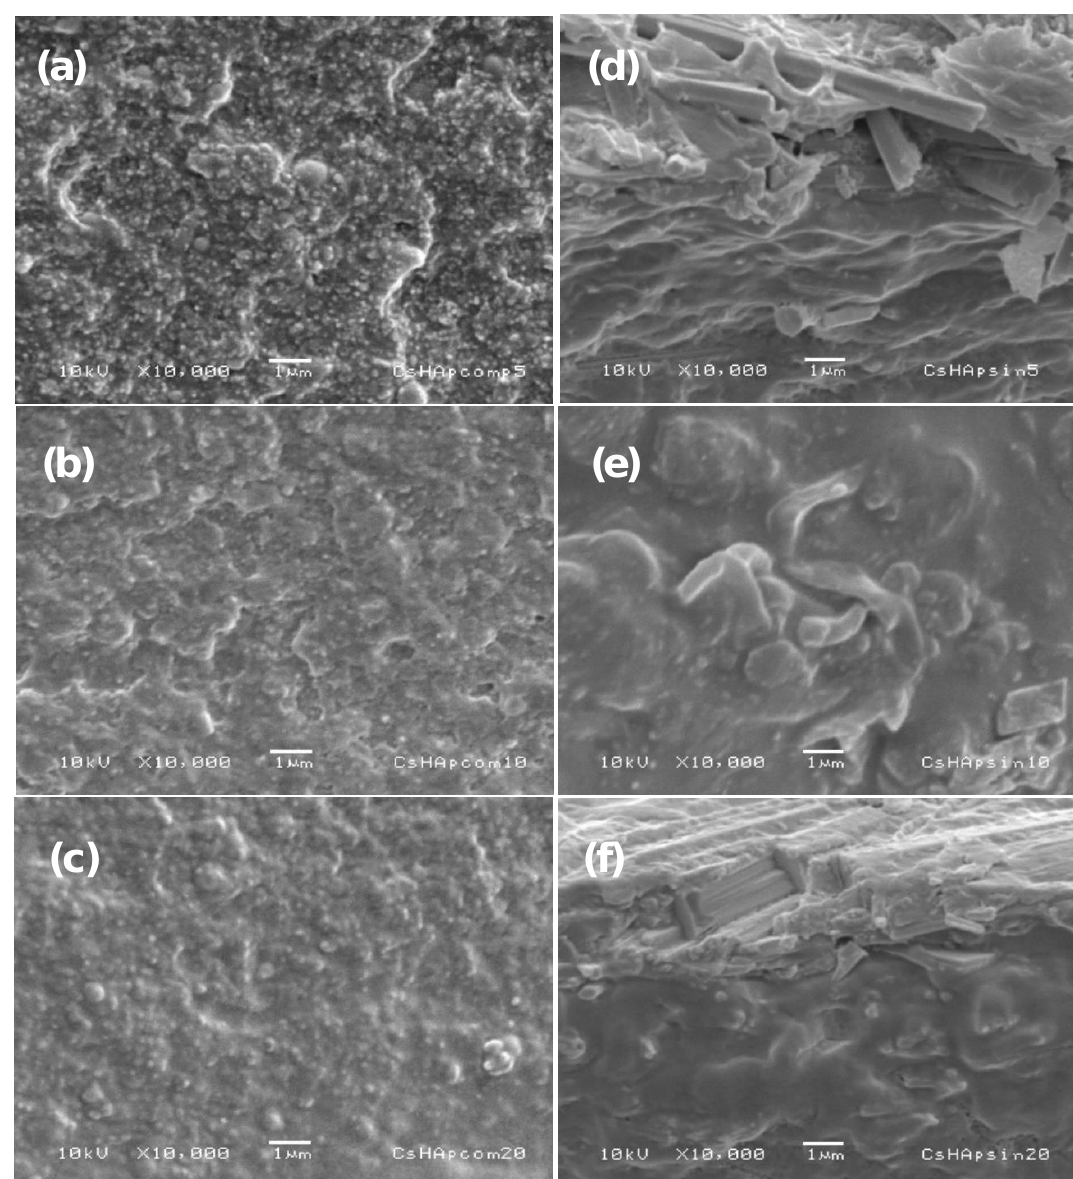
Figure 6. SEM secondary-electron micrographs of reference materials ( a – c ) and of HAp nanofibers/chitosan composite materials ( d – f ).